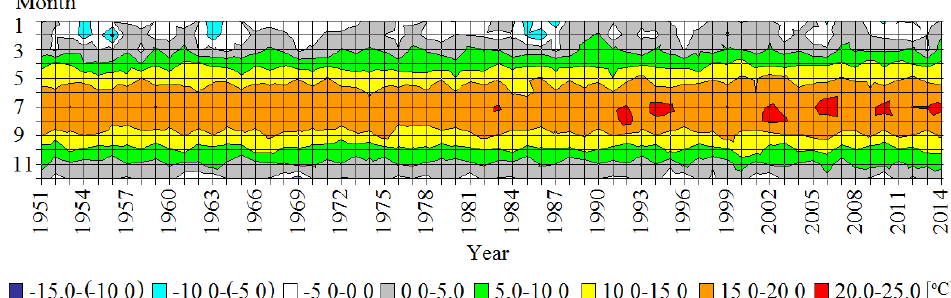
Figure 2. Monthly time distribution of air temperature (Ta) in the studied region, 1951–2014.